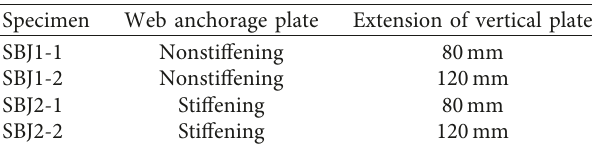
Table 1: Details of the test